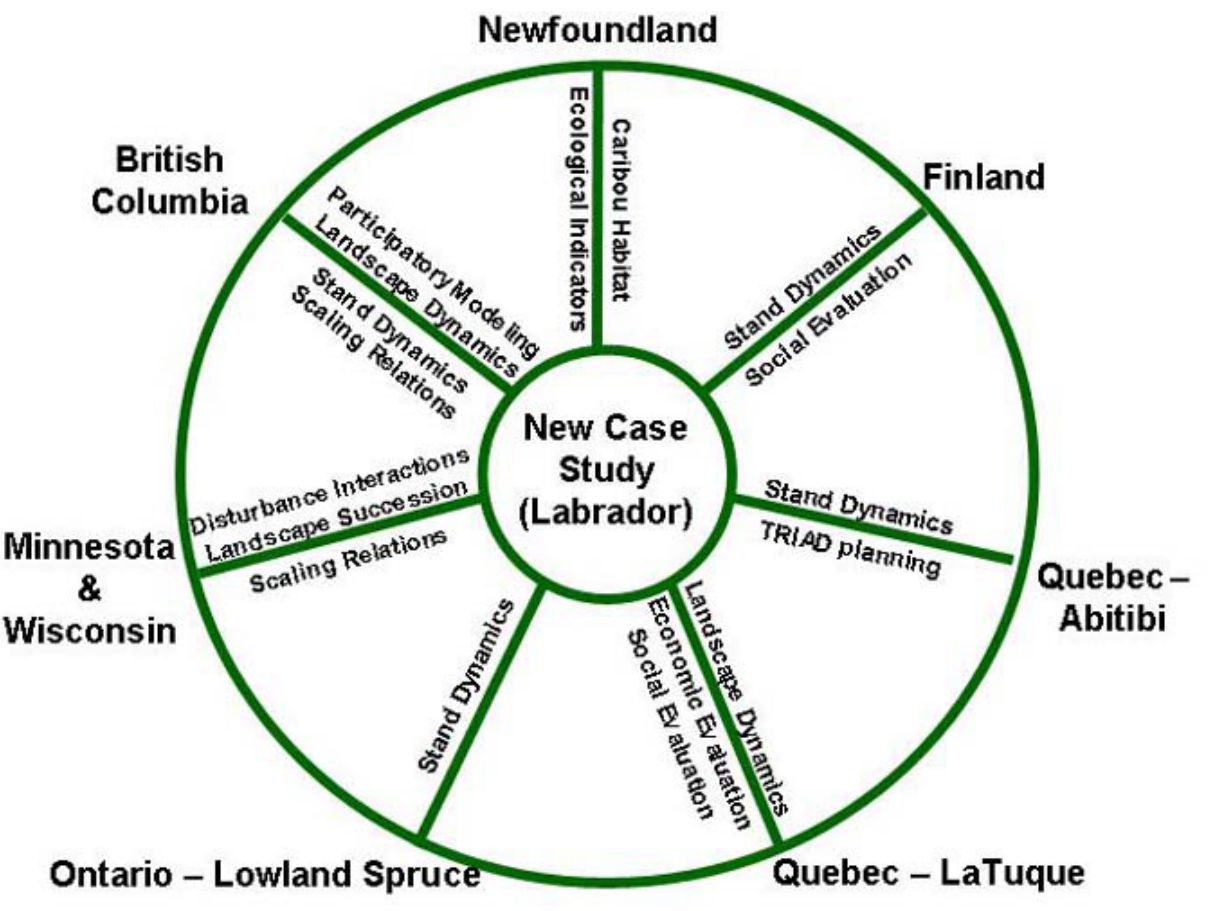
Fig. 1. Modeling teams in new landscapes can avoid “reinventing the wheel” by building on the knowledge, insights, tools, and experiences of previous modeling initiatives. The SFM toolkit approach discussed in this paper is built upon this philosophy. Commonality among case studies is visualized as a wheel, where insights and modeling tools from each region (spokes) make up the toolkit to be applied to a new case study (hub). Studies represented in this diagram share some common ecological attributes (i. e., boreal forests, fire) and anthropogenic interactions with the landscape (e.g., harvesting, conservation), but differ enough in context, questions, and issues addressed to make unique contributions to the new case